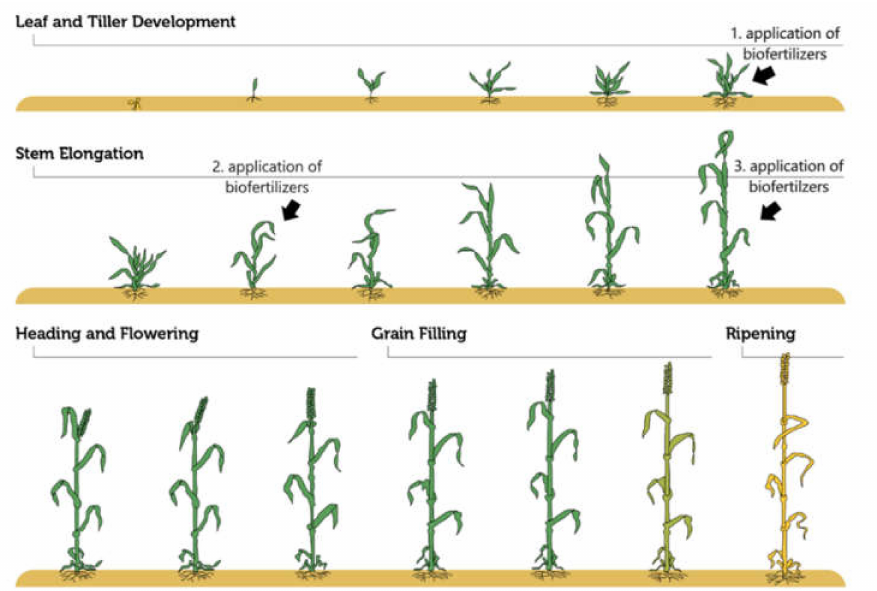
Figure 1. Phenological phases of wheat development. Black arrows indicate the developmental stage of the plant in which biofertilizers have been applied. Figure was adopted and then modified from eKonomics (https://nutrien-ekonomics.com/; 7.3.